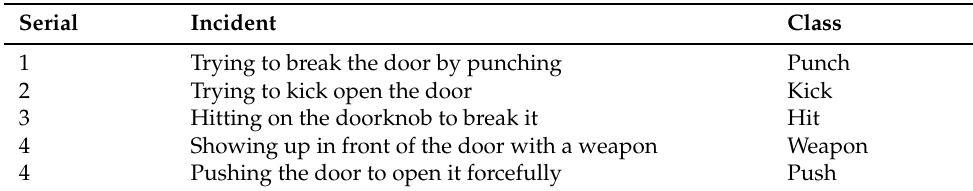
Table 2. Description of the incidents and class